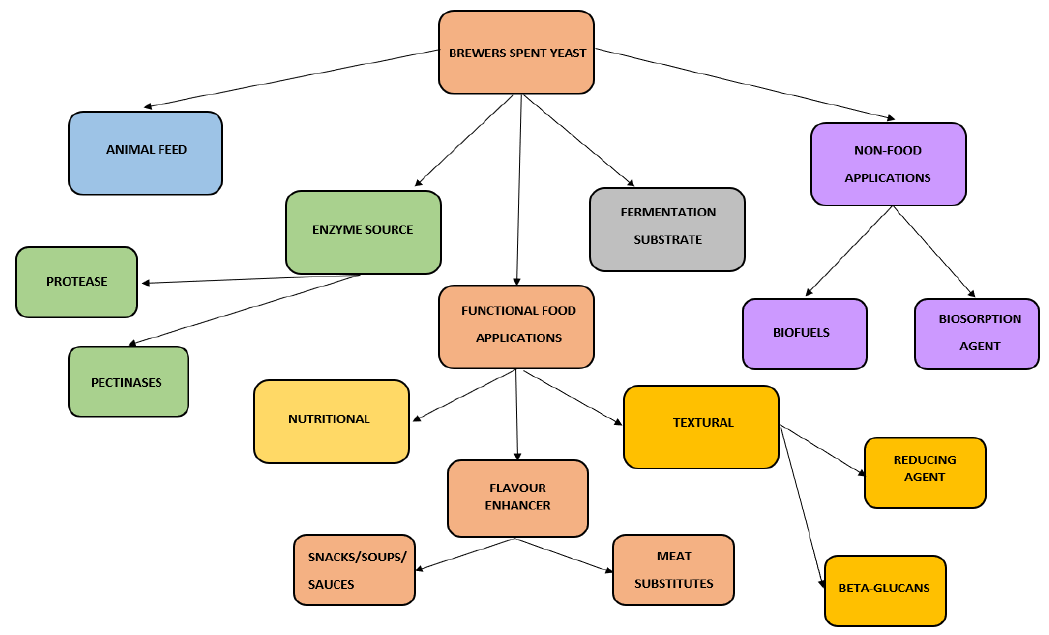
Figure 2. Overview of Current and Potential BSY Applications.